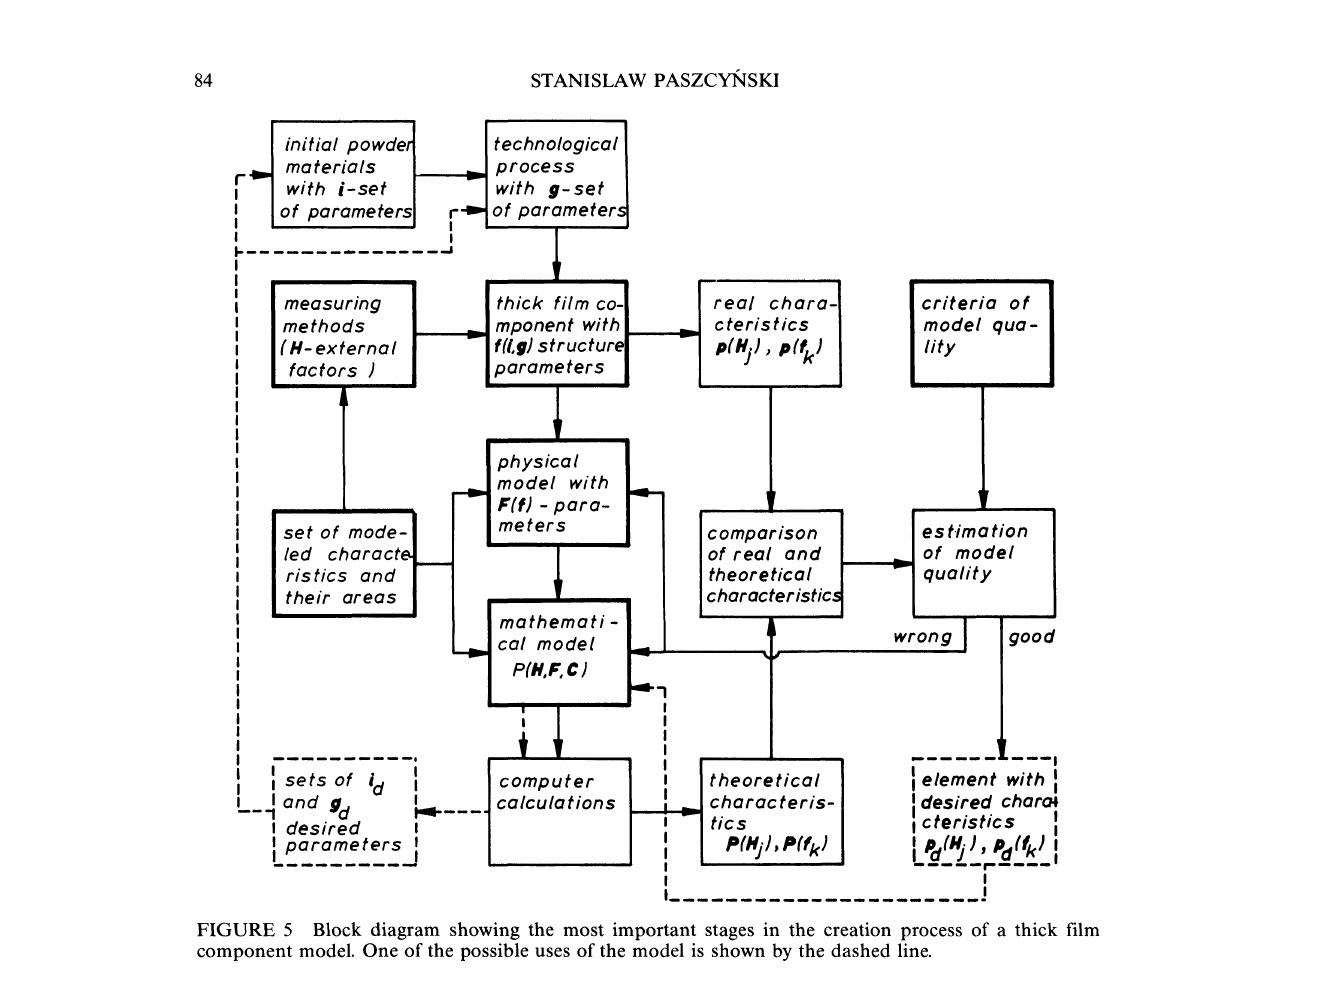
FIGURE 5 Block diagram showing the most important stages in the creation process of a thick film component model. One of the possible uses of the model is shown by the dashed line. of the important parameters of the component (it could be resistance R in resistors, B-constant in thermistors defined by equation